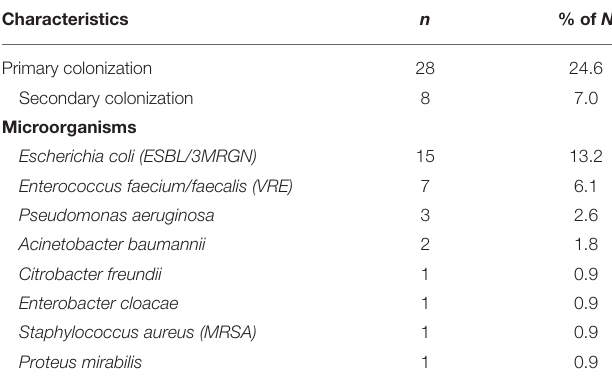
TABLE 6 | Bacterial carriage in trauma patients ( N =